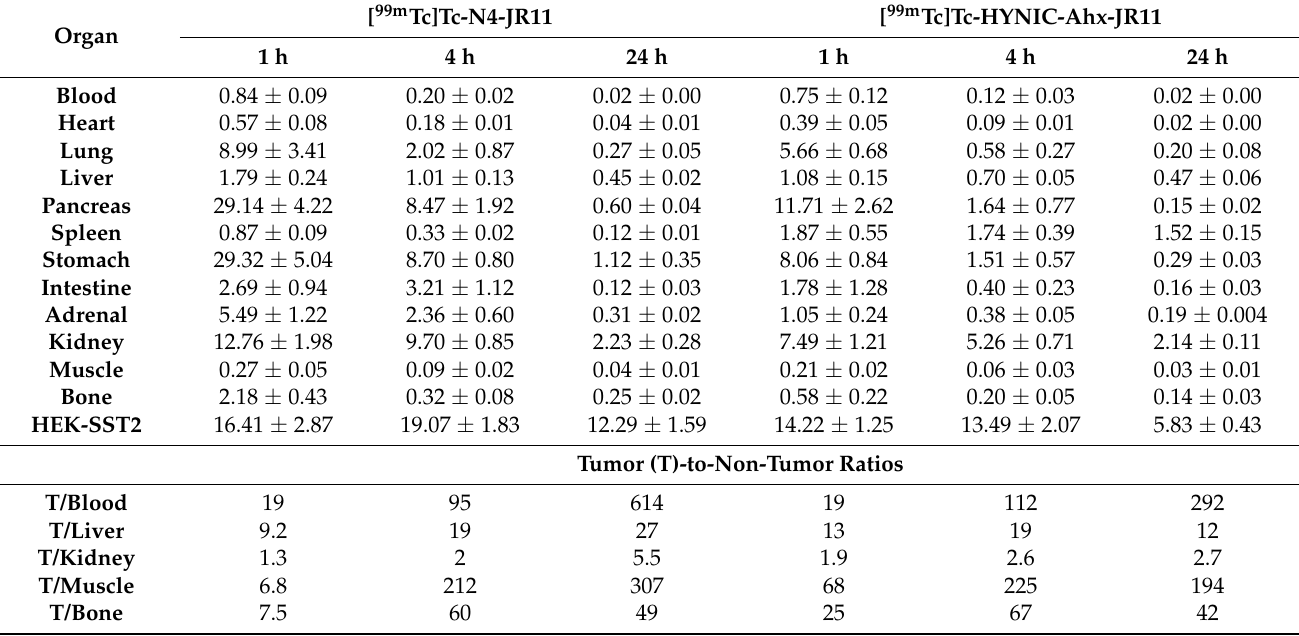
Table 3. Biodistribution studies of [ 99m Tc]Tc-N4-JR11 and [ 99m Tc]Tc-HYNIC-Ahx-JR11 in SST2-expressing xenografts at 1 ( n = 4), 4 ( n = 4) and 24 ( n = 3) hours p.i. Results are expressed as mean of the % injected activity per gram of tissue (% IA/g) ± standard deviation